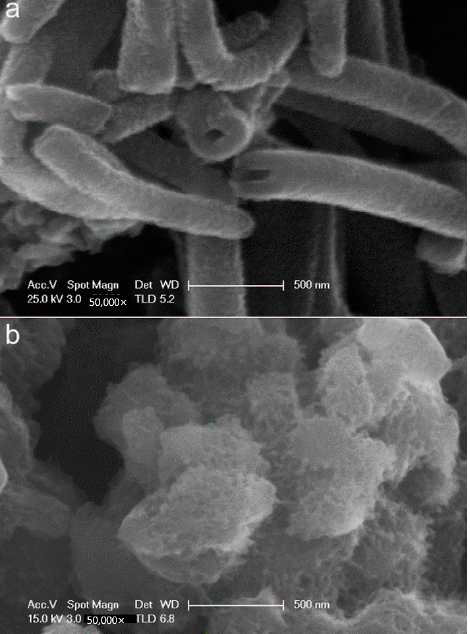
Figure 1. SEM images of PANI nanotubes ( a ), and aggregated ( b ).